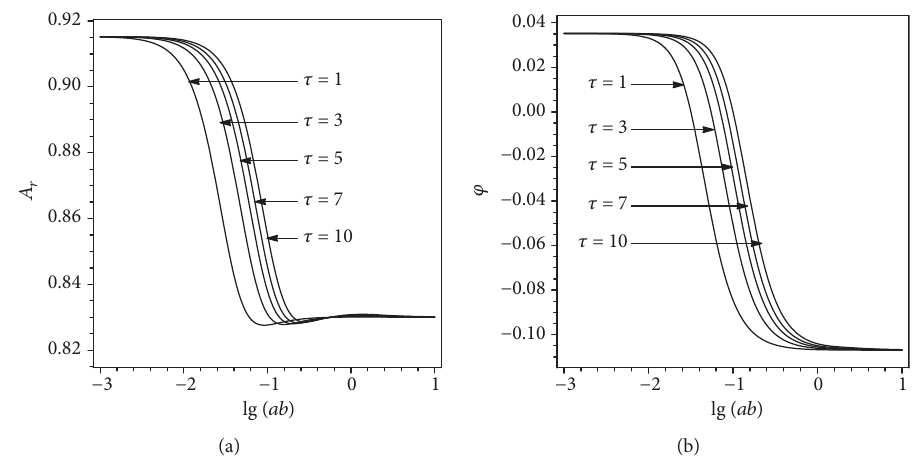
Figure 7: Changes of (a) amplitude ratio A for di ff erent values of τ ( τ = b / b ′ ). The loading coe ffi cients L